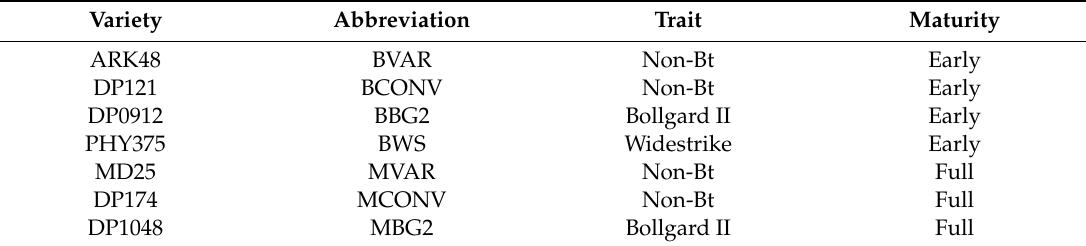
Table 1. Attributes of cotton varieties planted during 2011 and